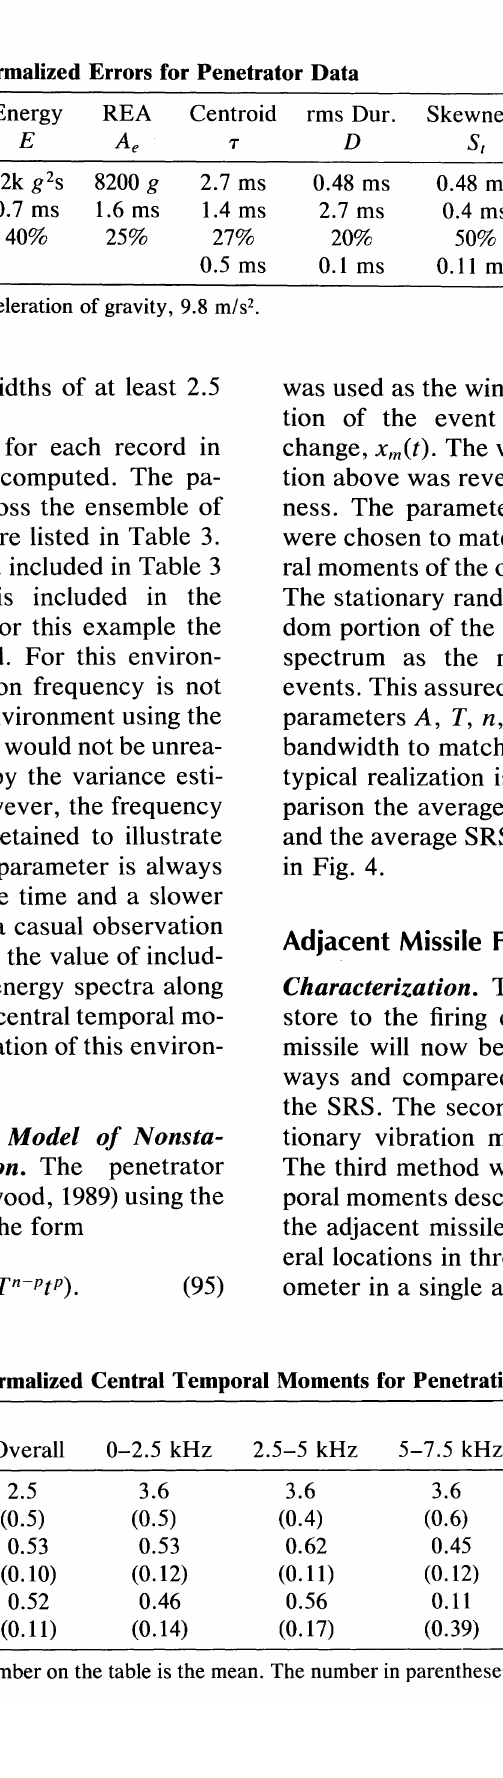
Table 2. Normalized Errors for Penetrator Data Energy REA Centroid E Ae